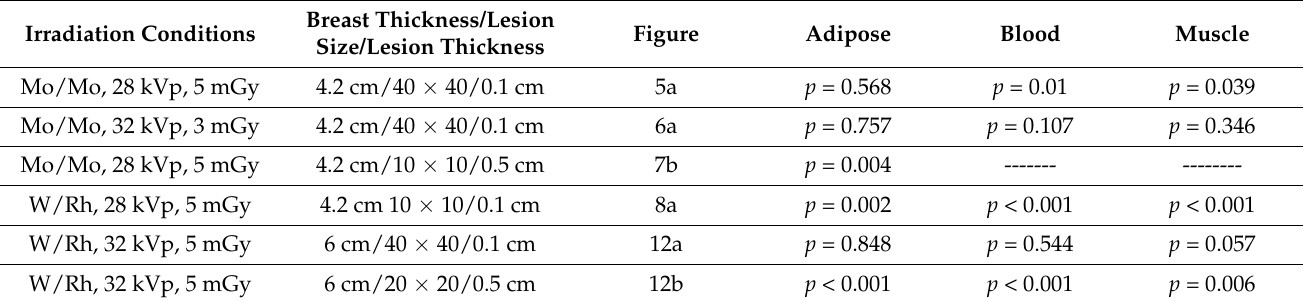
Table 1. Results for ANOVA test for the low-contrast objects under investigation with respect to the background.